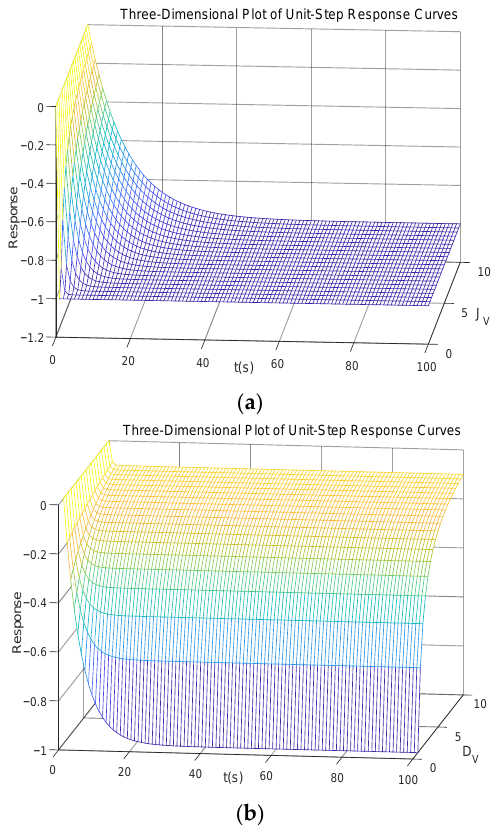
Figure 8. Step responses of T vp with the changing of J V and D V . ( a ) J V changing from 0 to 10 when D V = 1; ( b ) D V changing from 1 to 10 when J V = 5.